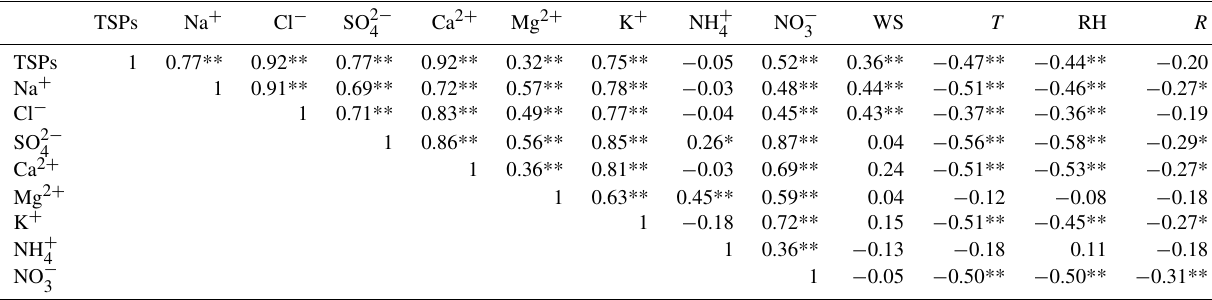
Table 3. Correlation coefficients among major ions in aerosol and meteorological